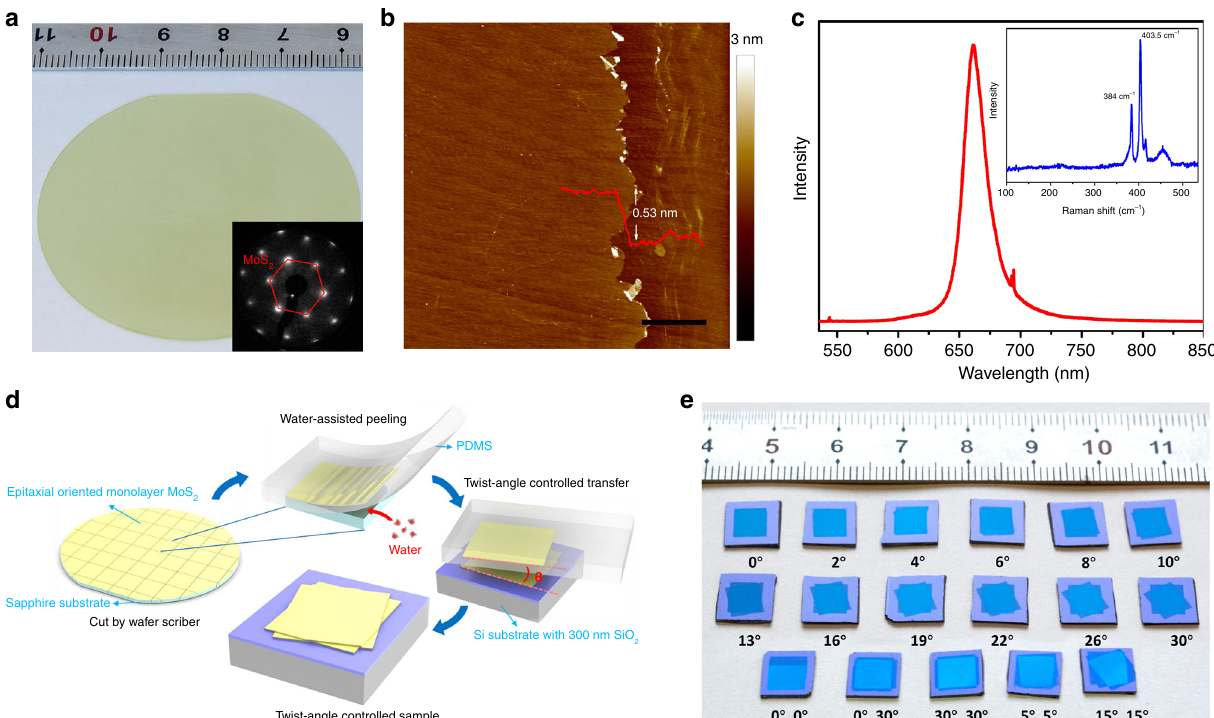
Fig. 1 Twist angle engineering of multilayer MoS 2 homostructures. a Image of as-grown MoS 2 monolayer on a 2-inch sapphire wafer, inset is a typical LEED pattern of the as-grown wafer. b AFM image of as-grown oriented MoS 2 monolayer after scraping off the right part of MoS 2 monolayer, scale bar 2 μ m. The height of the fi lm is ~0.53 nm. c Raman and PL spectra of as-grown MoS 2 monolayer. d The water-assisted transfer process. Polydimethylsiloxane (PDMS) are used as transfer medium. e Image of multilayer MoS 2 fi lms with precise-controlled twist angles on Si substrates with 300 nm SiO 2 . Source data are provided as a Source Data fi